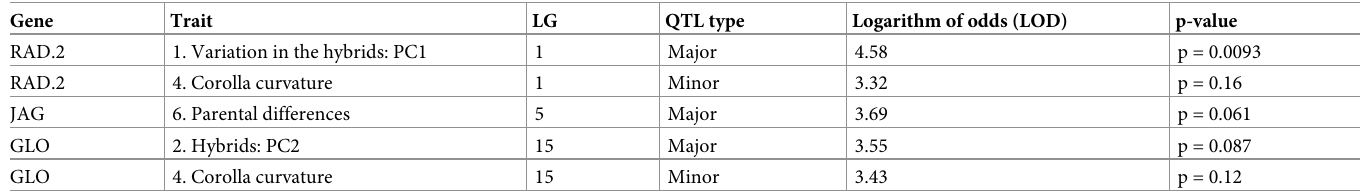
Table 3. Candidate genes that have a logarithm of odds (LOD) greater than three (1000 to 1 odds) for an association with a floral trait, along with the statistical probability of association as determined by permutation of the linkage map. Gene